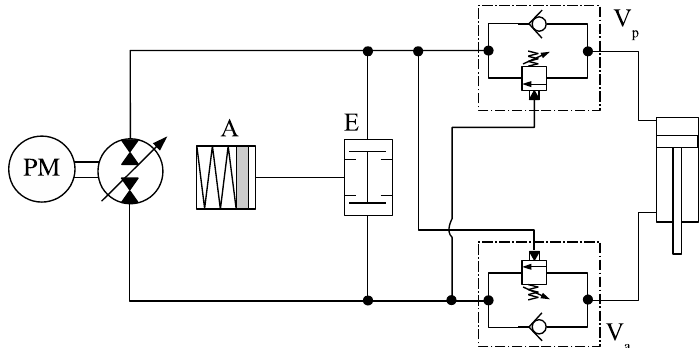
Figure 23. ( a ) External force, cylinder velocity and compensation flows ( (cid:1868) (cid:2913)(cid:2928) = 3 bar ); ( b ) cap- and rod- side pressures ( (cid:1868) (cid:2913)(cid:2928) = 3 bar ); ( c ) external force, cylinder velocity and compensation flows ( (cid:1868) (cid:2913)(cid:2928) = 0.1 bar ); ( d ) cap- and rod-side pressures ( (cid:1868) (cid:2913)(cid:2928) = 0.1 bar ). Recently, the circuit shown in Figure 24 was proposed [11], where the directional valve C in